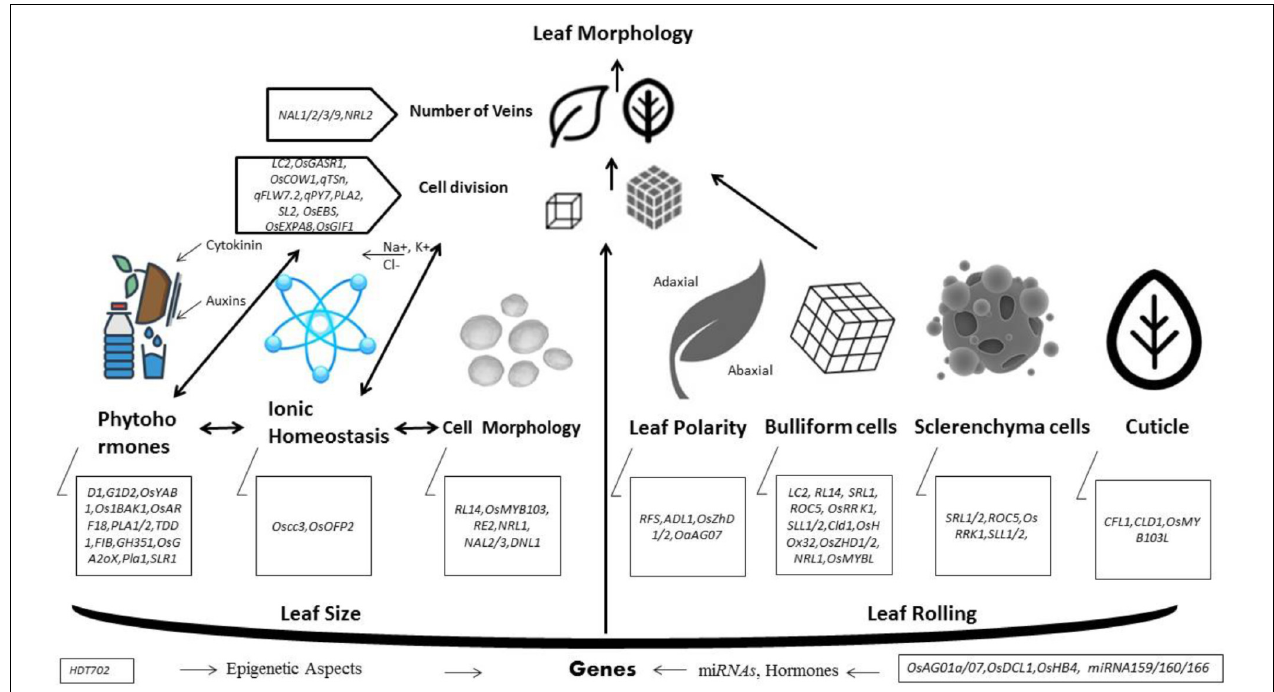
FIGURE 1 | A hypothetical model to understand working of genes regulating leaf